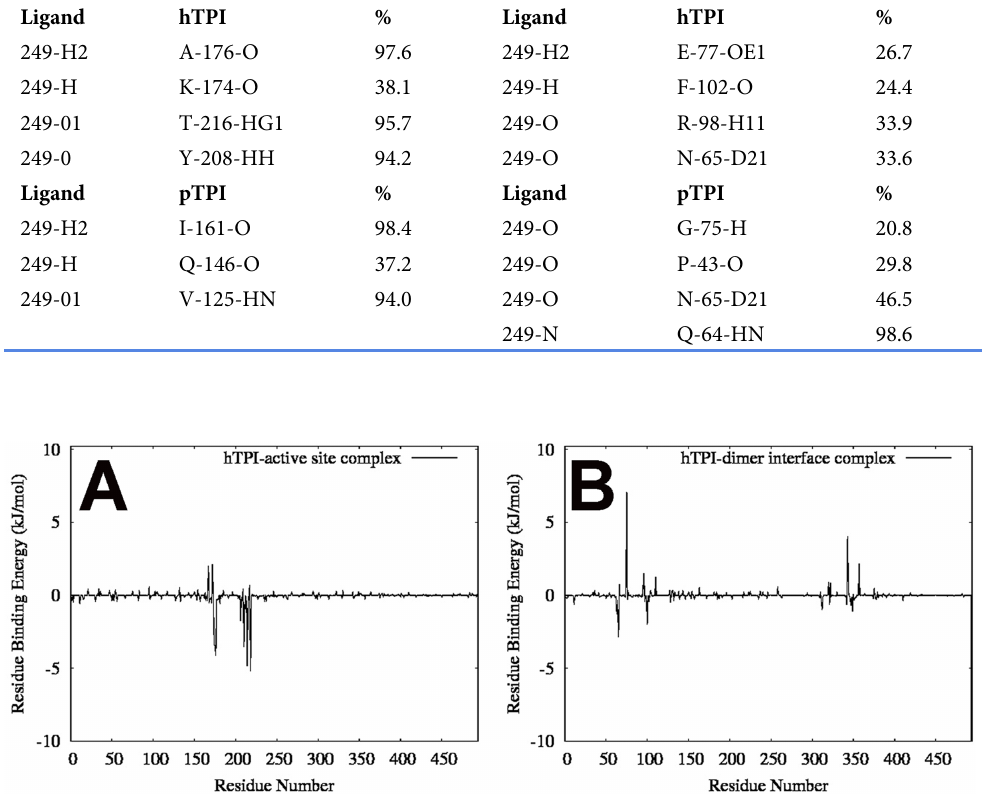
Figure 9 Individual residue contribution to the binding energy for each complex. Residues 1 – 248 corresponds to chain A and residues 249 – 496 correspond to chain B. (A) hTPI-Active Site binding energy contribution from residues, (B) hTPI-dimer interface residue contribution.